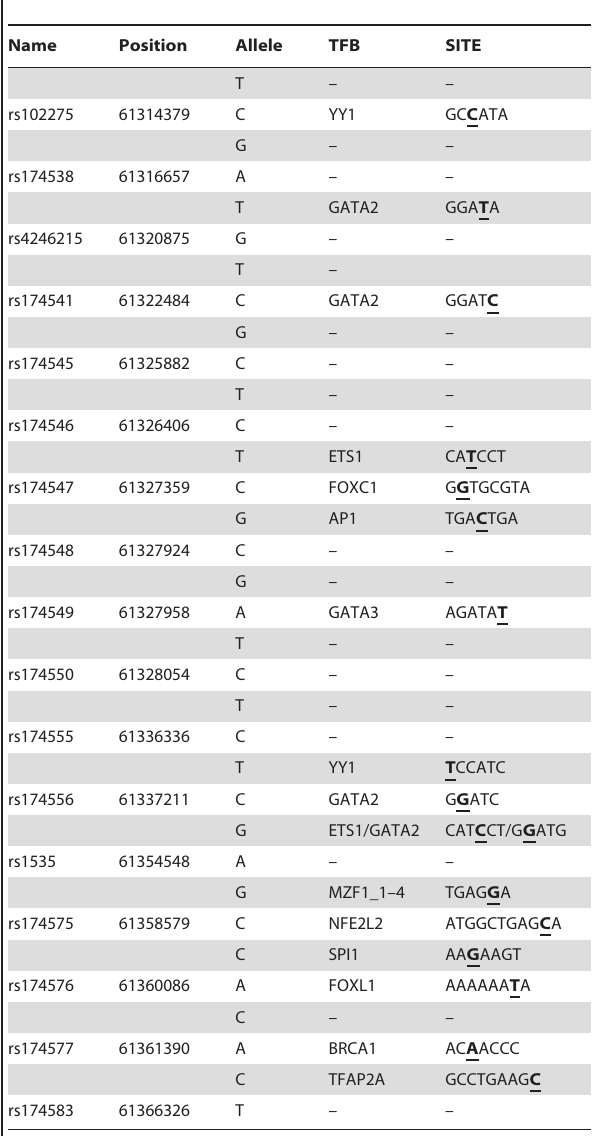
Table 6. Schematic representation of human TF binding sites prediction in the surrounding regions of the 16 SNPs associated with FADS1 brain expression and Caspi et al associated SNP rs174575 [25] using JASPAR (scoring matrices above